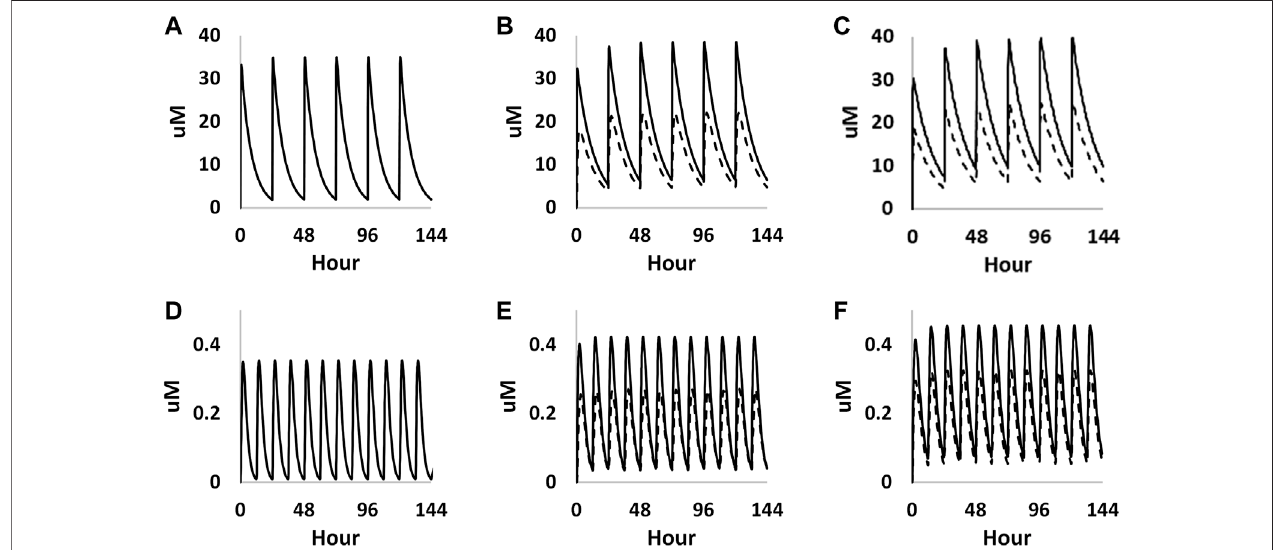
FIGURE9| PBKsimulationsonplasmaconcentrationtimepro fi lesofcaffeineinbothmother(solidcurves)andfoetus(dashedcurves)throughdifferentgestational ages. (A – C) representprediction on week6, week 20and week 30from oral exposure, respectively. (D – F) representpredationson week 6,week 20and week30from dermal exposure, respectively.